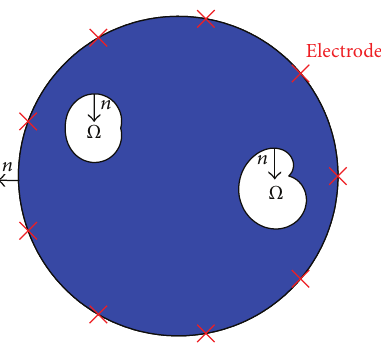
Figure 11: Geometry for the impedance tomography